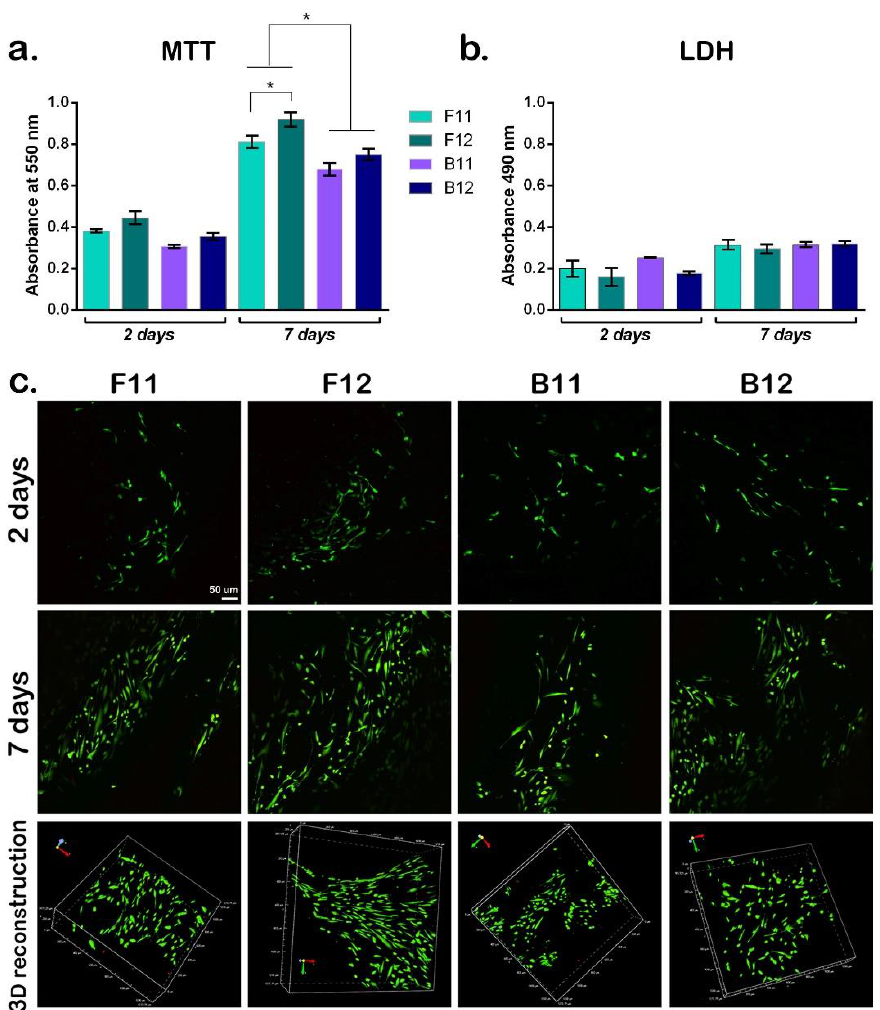
Figure 5. Biocompatibility evaluation of the acellular scaffolds. Cells were seeded on top of the scaffolds and biocompatibility was evaluated after 2 and 7 days of culture in standard conditions. ( a ) Cell viability and proliferation profiles obtained by MTT assay. Statistical significance: * p < 0.05. ( b ) GelMA-based scaffolds’ cytotoxicity profiles measured by LDH assay. ( c ) Qualitative evaluation of cell viability and proliferation was assessed employing Live/Dead assay and confocal microscopy. Live cells are stained in green fluorescence, while dead cells nuclei are stained in red fluorescence Waltham, MA, USA.). Scale bar 50 µm.